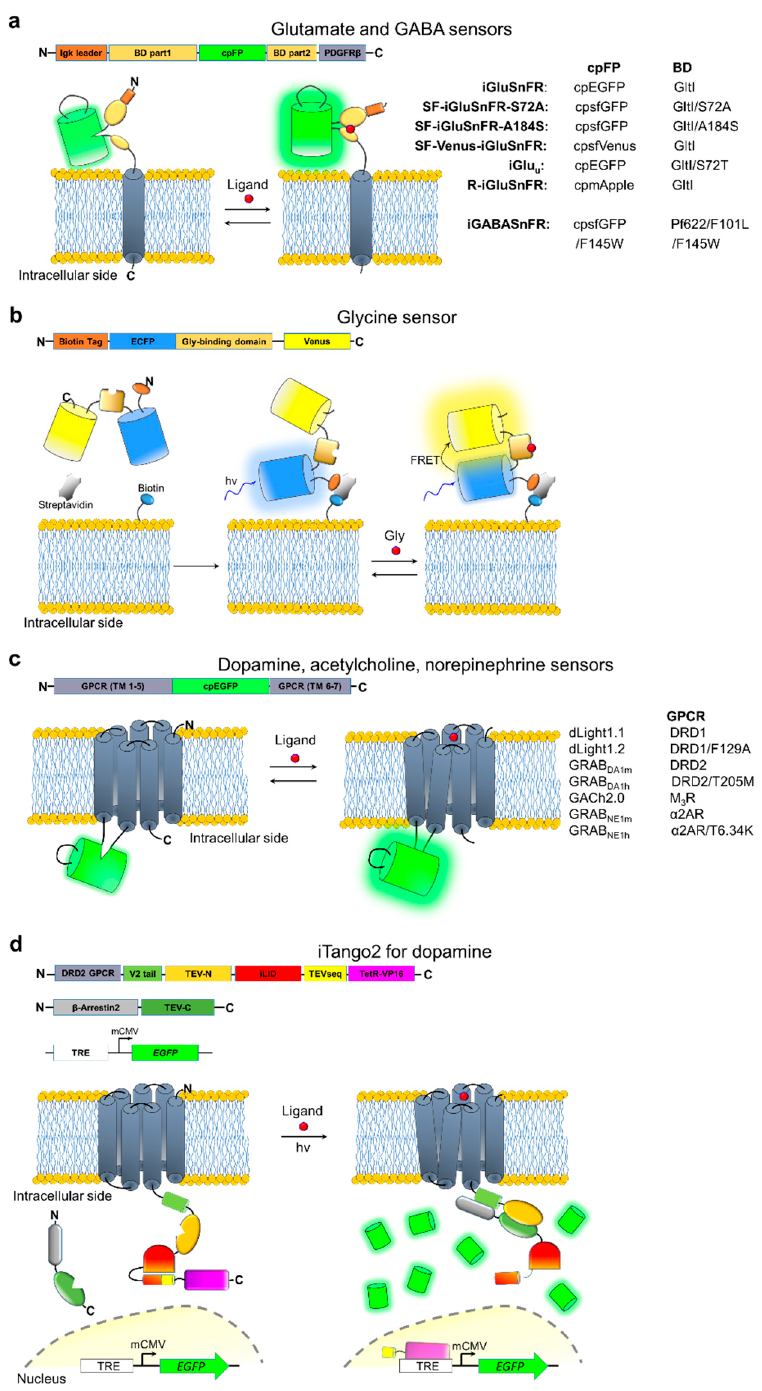
Figure 3. Molecular design of genetically-encoded neurotransmitter indicators. ( a ) PBP-based glutamate and GABA sensors. ( b ) PBP-based glycine sensor. ( c ) GPCR-based dopamine, acetylcholine, and norepinephtine sensors. ( d ) iTango2 system for dopamine detection.